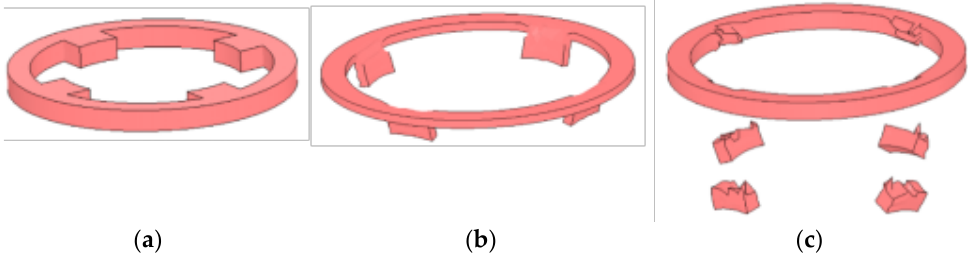
Figure 8. Three typical damage modes of shear slice: ( a ) micro-deformation, ( b ) full plastic defor- mation, ( c ) local fracture.